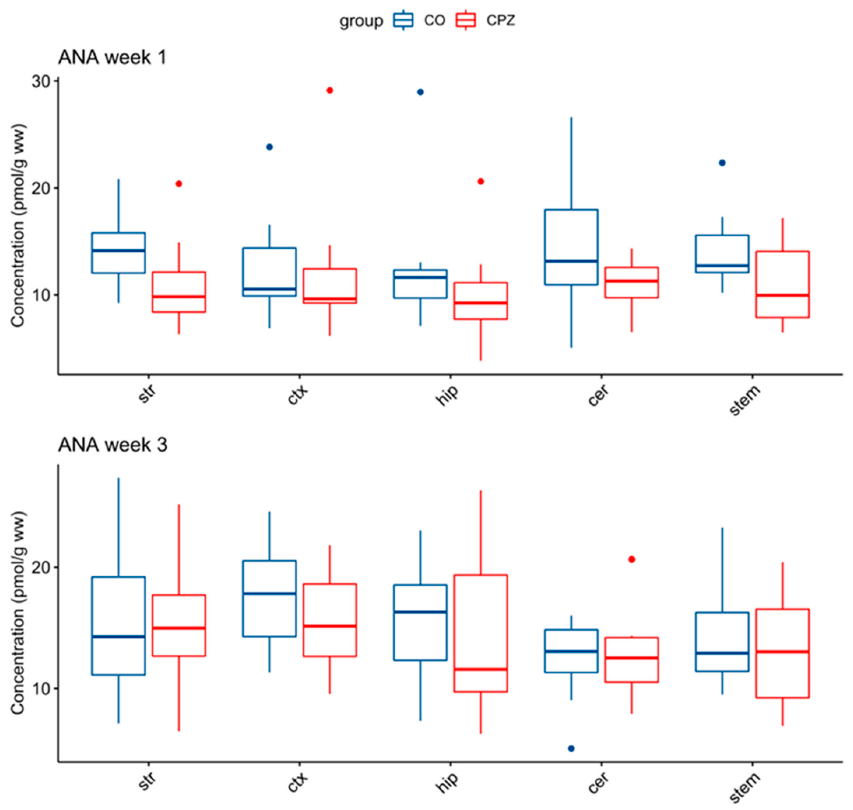
Moreover, in addition to the differences in 3-HK and TRP levels, there was also a significant decrease in ANA concentration by the 5th week of CPZ intoxication in the striatum, the cortex, the hippocampus, and the brainstem of the CPZ group compared to the CO (Figure 7).